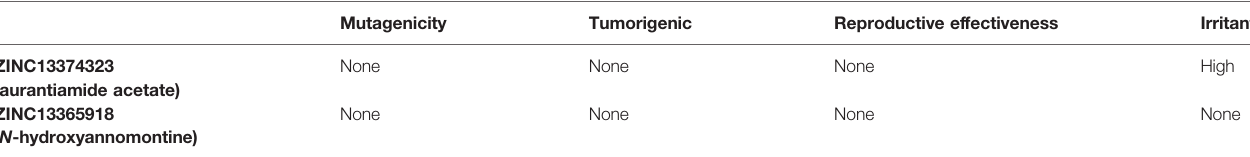
TABLE 3 | Toxicity pro fi le of potential lead